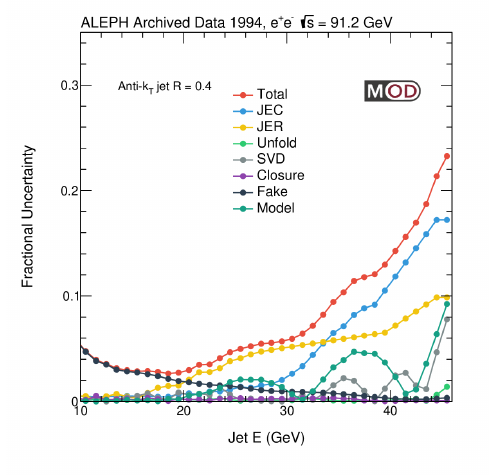
Figure 6 . Summary of the size of relative systematic uncertainty from different sources for jet E .